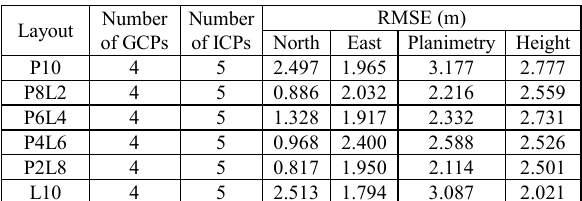
Table 6. Block adjustment accuracy of the ZY-3 TLC images in the dataset